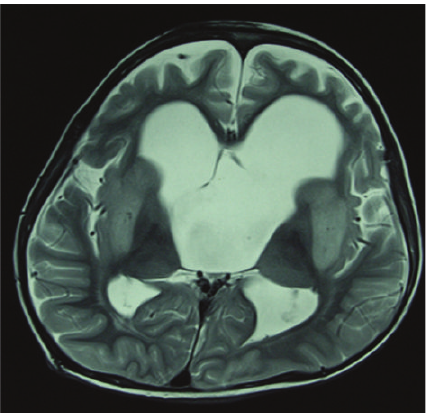
Figure 1: The preoperative of MRI image showed a cyst lesion at the suprasellar cistern which compressed the third ventricle (T2 weighted image).